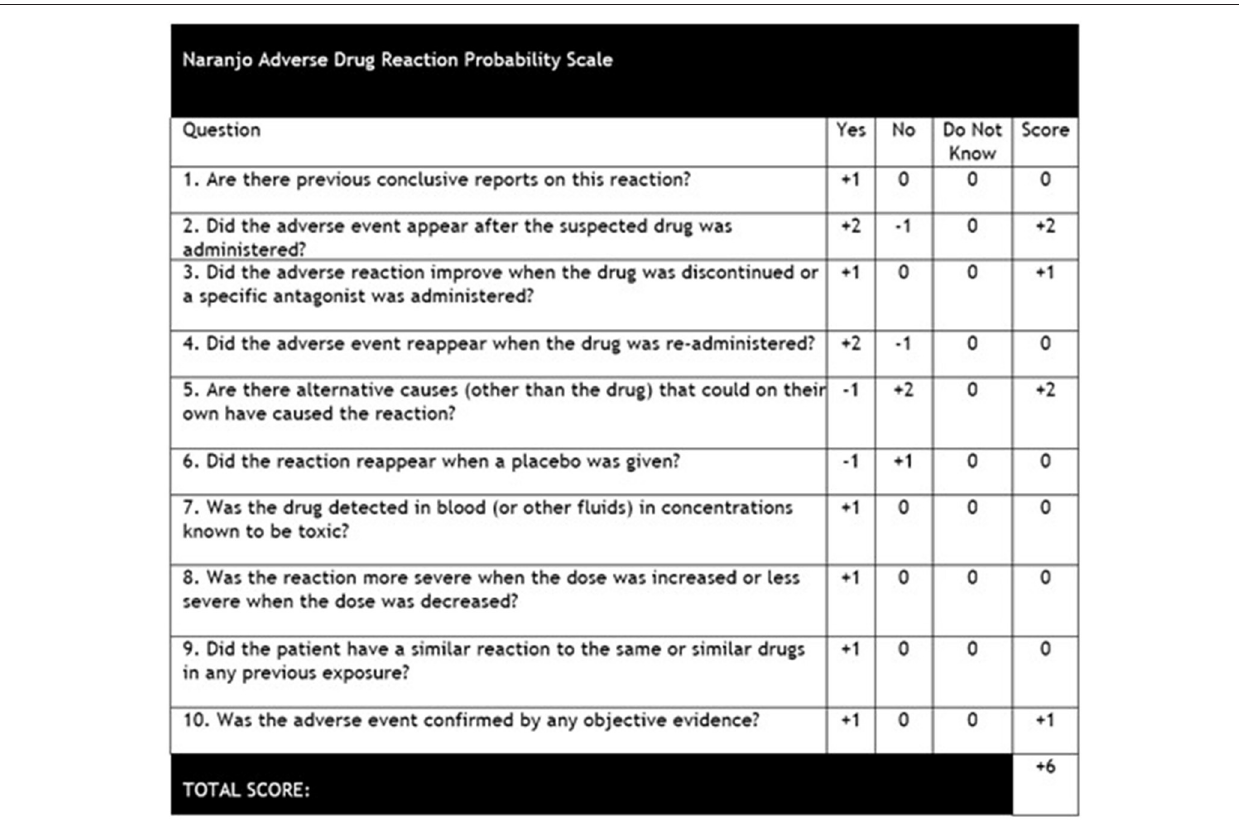
Frontiers in Neurology |